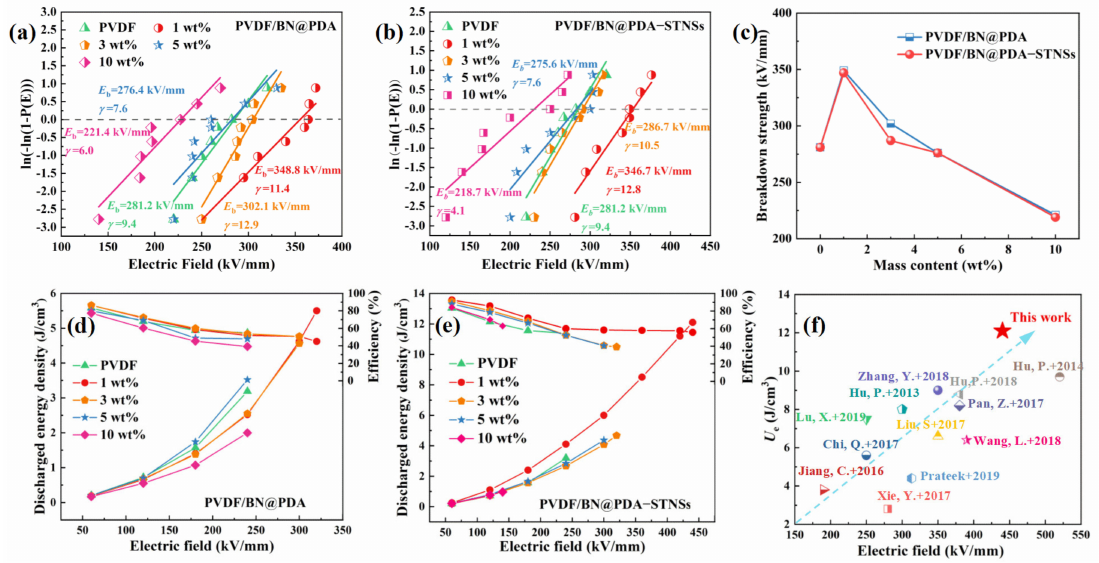
Figure 7. Two-parameter Weibull distribution plots of ( a ) PVDF/BN@PDA and ( b ) PVDF/BN@PDA − STNSs composites. ( c ) Variation of characteristic breakdown strength of PVDF/BN@PDA and PVDF/BN@PDA − STNSs composites with increasing filler content. Discharged energy density ( U e ) and efficiency ( η ) of ( d ) PVDF/BN@PDA and ( e ) PVDF/BN@PDA − STNSs. ( f ) Comparison of U e and E b of related state-of-the-art composites filled with different fillers, respectively